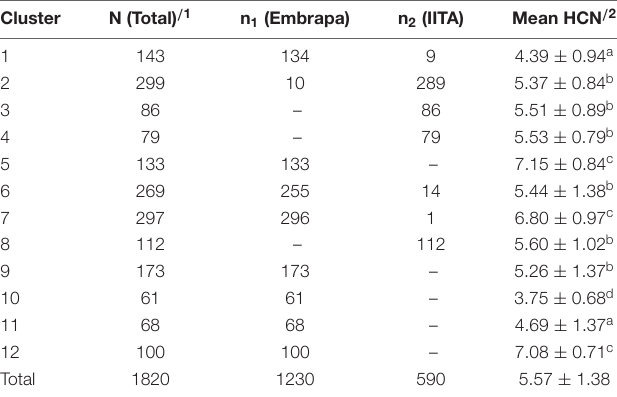
TABLE 3 | Discriminant analysis of principal components (DAPC) that accounted for most ( > 95%) of the total genetic variability and genetic clusters were inferred ( k = 12) based on Bayesian Information Criterion (BIC).